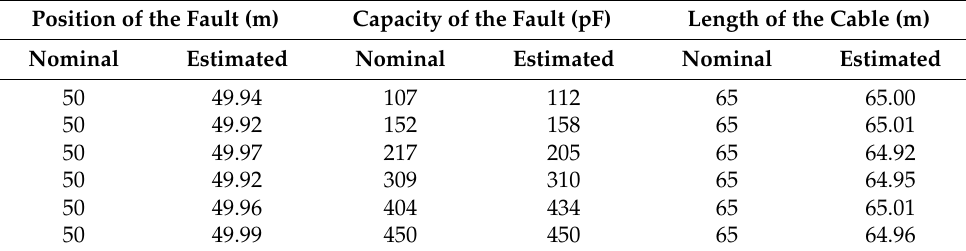
Table 4. Estimation results for real cables with one capacitive fault.